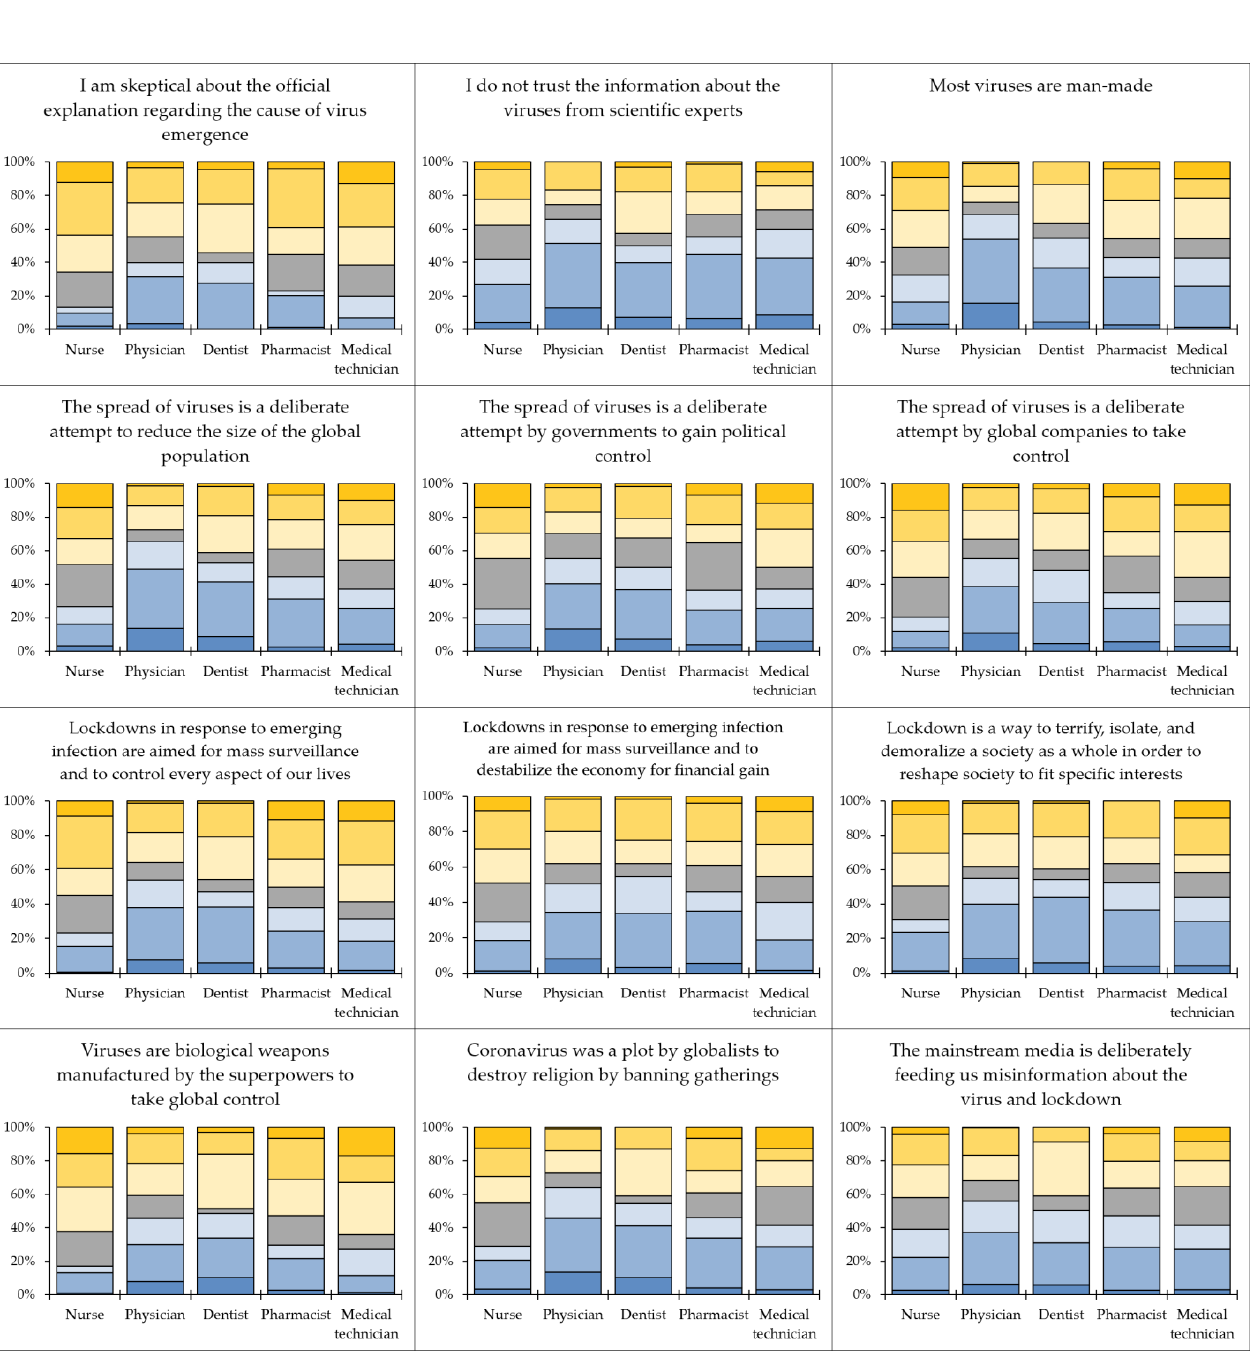
Figure 3. The attitude towards emerging virus infections conspiracy beliefs items in among healthcare workers who participated in this study divided by occupational category. Multinomial logistic regression analysis showed that EVICS ≥ 48 was independently correlated with inferior HMPX knowledge and with the agreement or neutral/no opinion belief in the role of male homosexuals in HMPX spread, while physicians showed the op- posite pattern (with medical technicians as the reference group, Table 3).